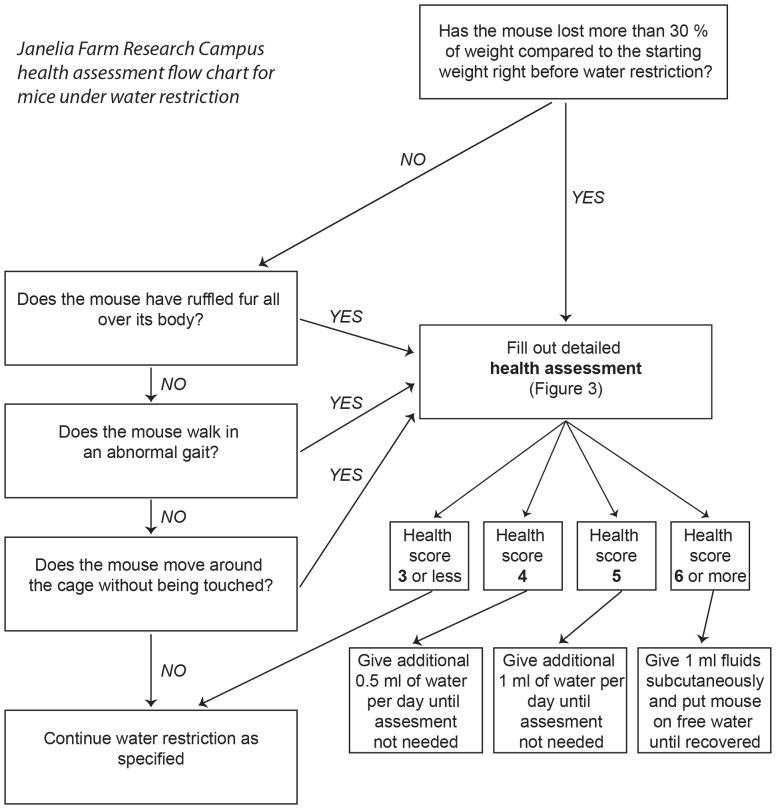
Flowchart for monitoring mice under water restriction.